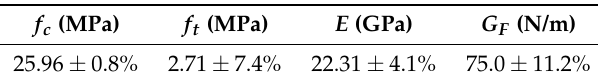
Table 1. Experimental results of concrete tests.